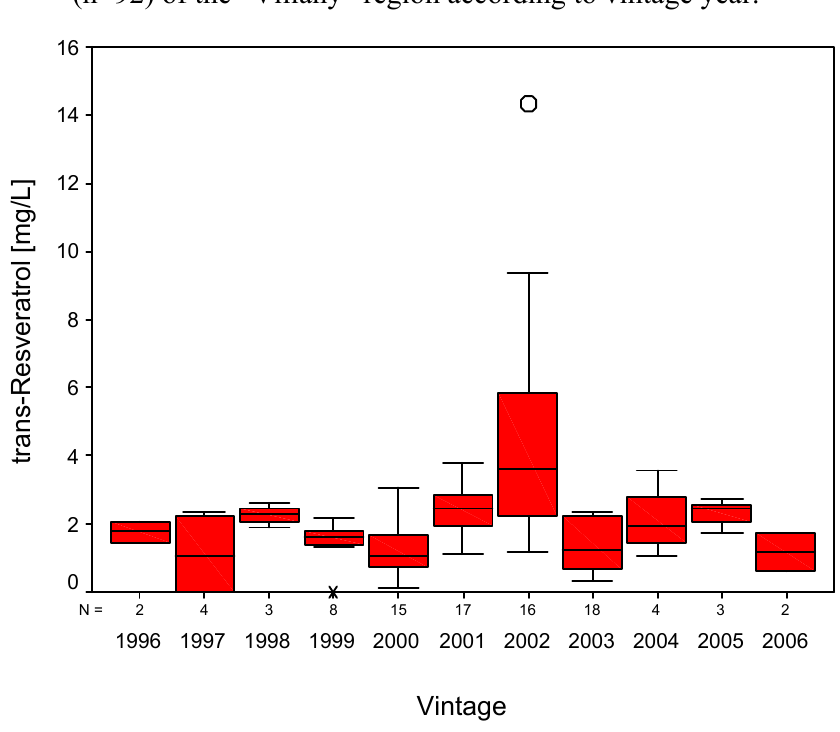
Figure 3. Trans-resveratrol content [mg/L] of Hungarian red wines (n=92) of the “Villány” region according to vintage